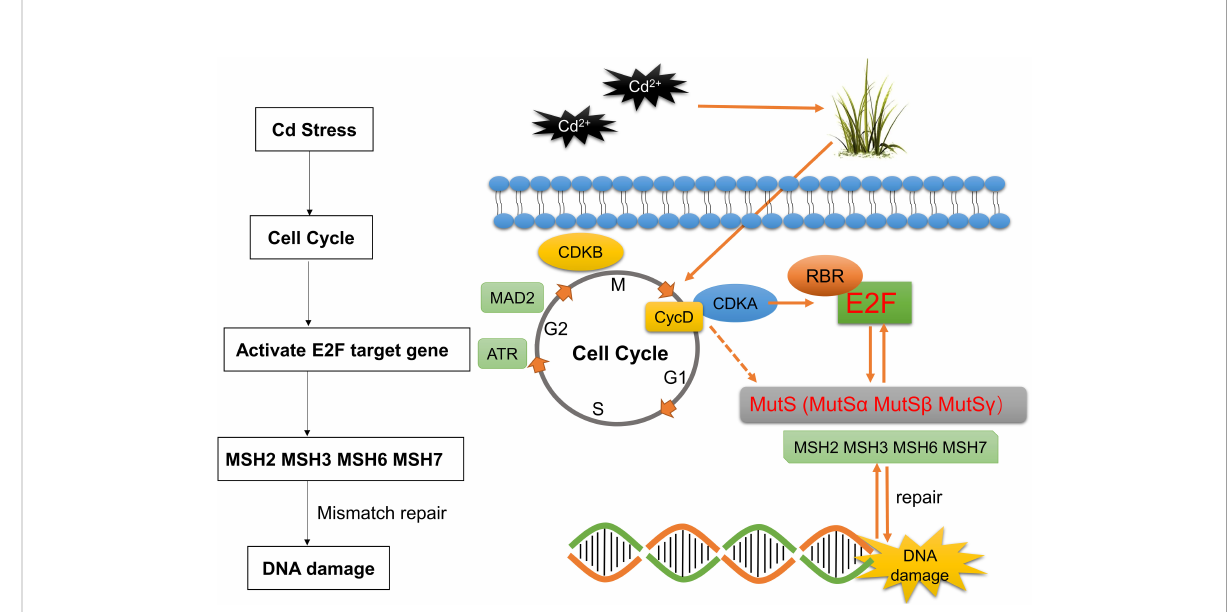
FIGURE 7 Model of Cd-induced cell cycle regulation in rice leaves. The solid line represents the critical pathway, the dashed line represents the possible pathway, and the technical route to the model is explained on the